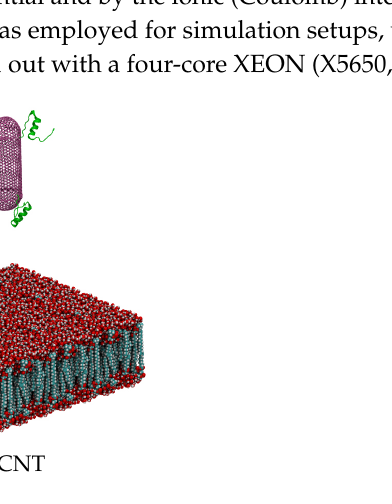
Figure 3. Atomic representation of two simulated systems (lipid bilayer atoms represented with their van der Waals radius; nanocarrier (fullerene and end-capped CNT) atoms are rendered with line representation (purple), and insulin chains are represented in